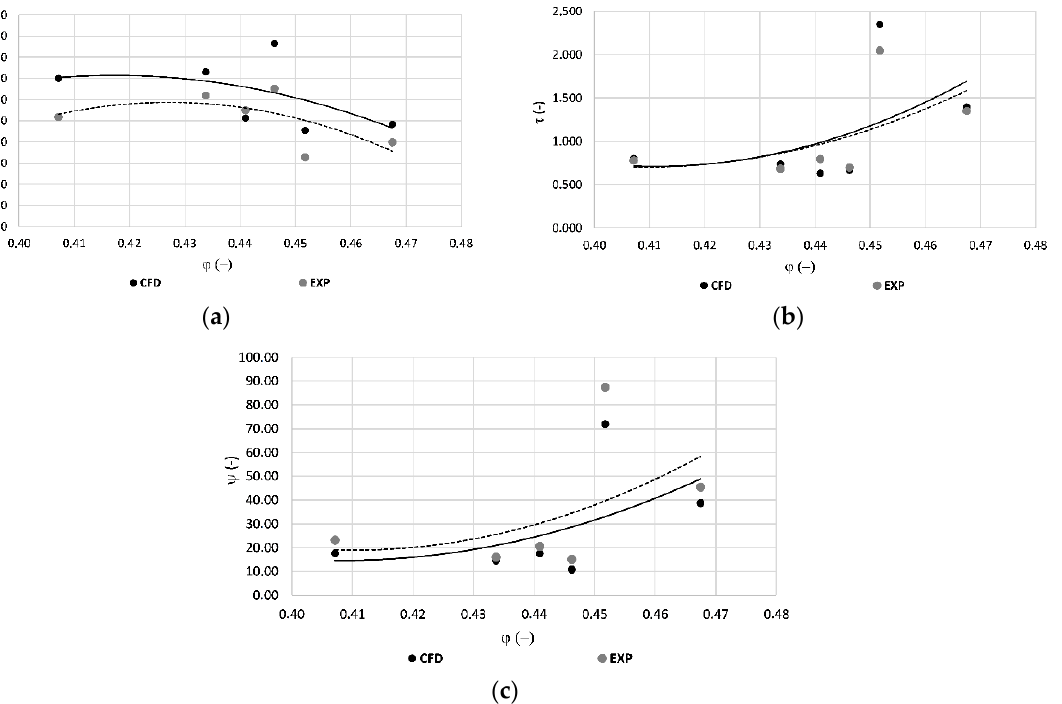
Figure 10. Comparison between experimental measurements and numerical results. ( a ) Efficiency vs. flow rate coefficient; ( b ) torque coefficient vs. flow rate coefficient; ( c ) head coefficient vs flow rate coefficient.